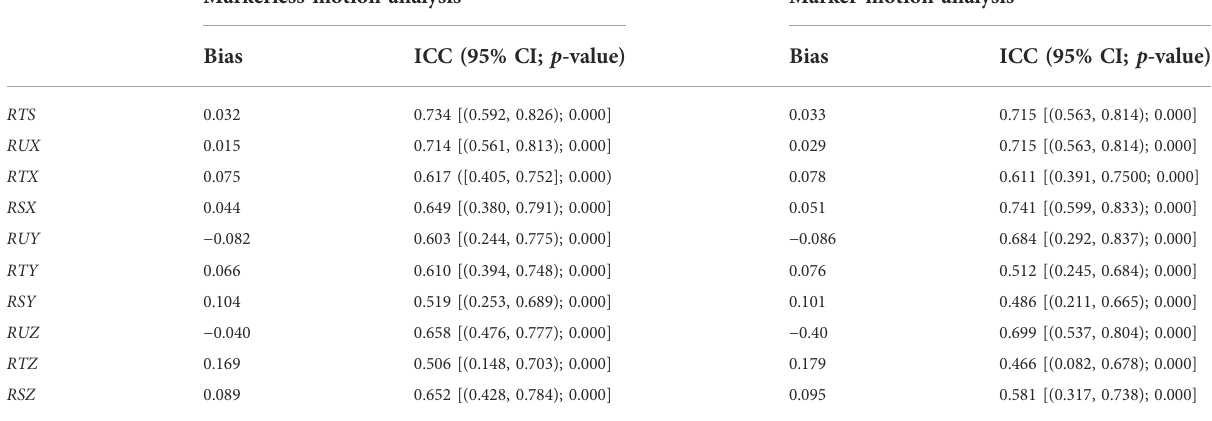
TABLE 2 Statistic property for marker and markerless motion analysis during test –